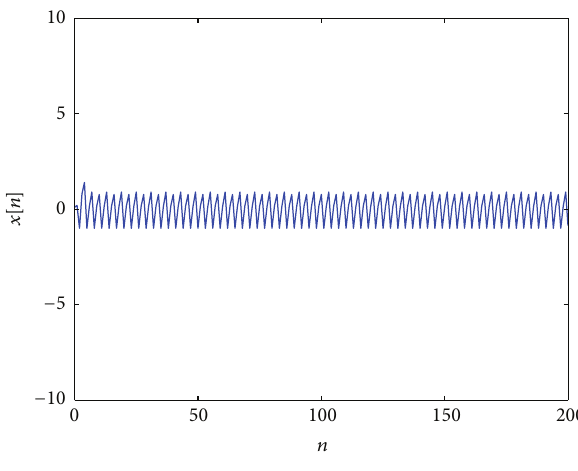
Figure 4: Periodic orbit satisfies condition (i).